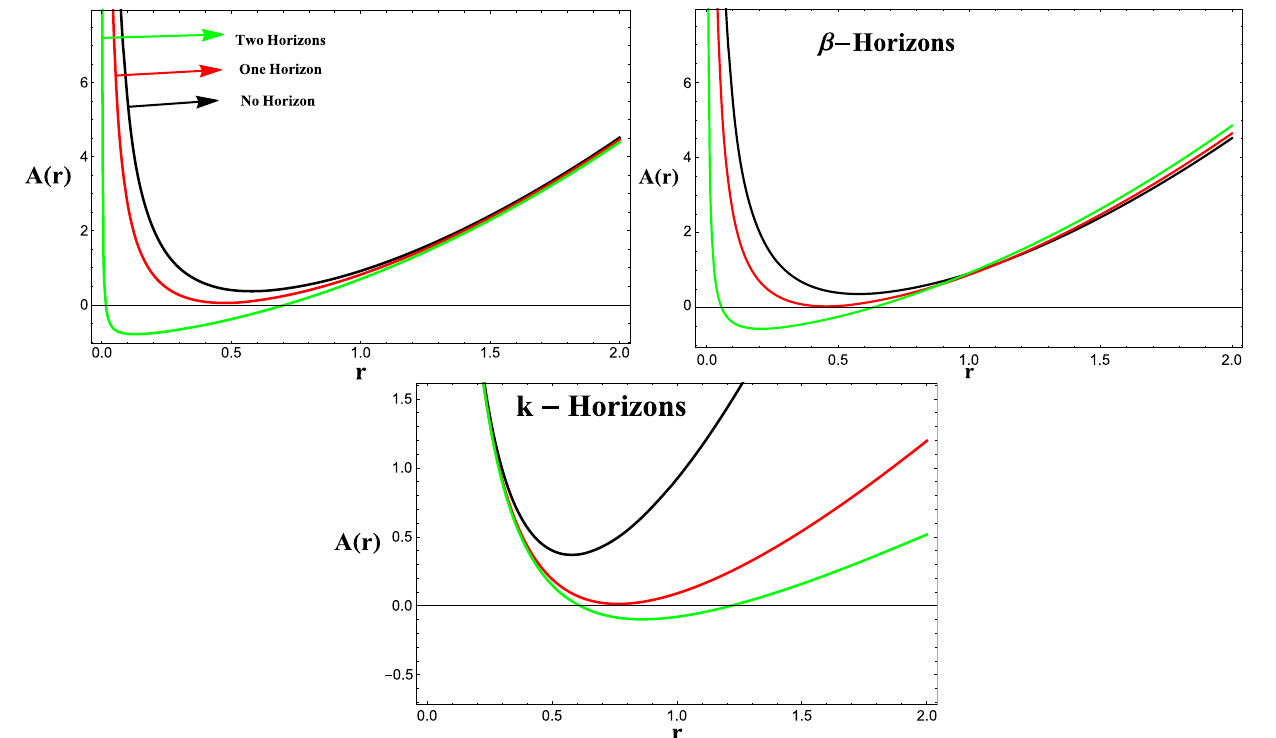
Fig. 1 The horizon structure of conformal BH displays the behavior of A ( r ) versus r . Left panel for various values of γ and others parameters are taken as fixed k = − 1, β = 0 . 96. In the right panel, β horizons mean, we take various values of β . In the bottom panel, k horizons mean, we take